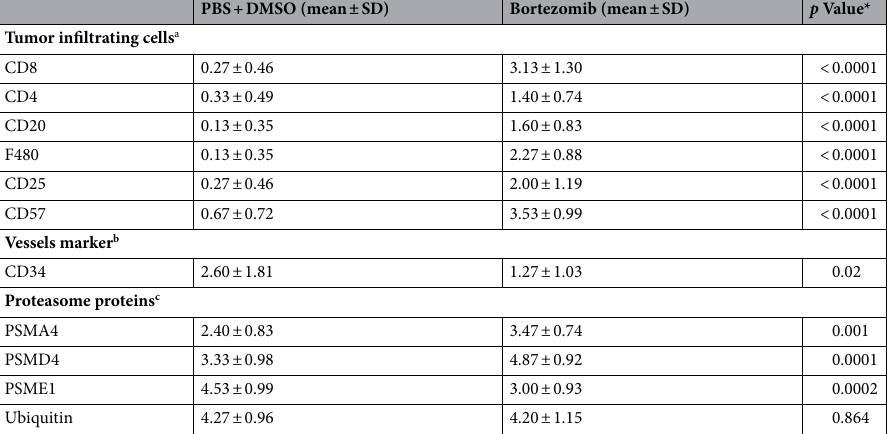
phosphatidylserine externalization in HNSCC cell lines 46,48–52,56,57. Bortezomib was shown to stimulate autophagy in HNSCC cells in two studies showing autophagosomes formation, upregulation of LC3-I, -II, Beclin-1 and the JNK-dependent phosphorylation of Bcl-2 after Bortezomib treatment 58,59 . It was also suggested that autophagy attenuated the Bortezomib cytotoxicity 59 . Bortezomib was able to modulate expression and activation of signal- ing pathways in HNSCC, by inhibiting AKT activation and mTOR 46,60 , and by upregulating STAT3 55 in HNSCC cell lines. Only two studies showed that Bortezomib affects proteasome activity by inducing the accumulation of ubiquitylated proteins in larynx (UM-SCC-11A, -11B) 56 and mouth floor (SCC1) cell lines 59 . It is worth pointing out that the majority of the studies investigated the effect of Bortezomib on the modulation of individual bio- logical pathways being restricted to SCC cell lines arising in head and neck. In our study the in vitro and in vivo The mainstream therapy for these types of cancer, when feasible, is the surgery followed by radiation therapy. Chemotherapy regimens have demonstrated controversial clinical outcomes with low responses for advanced